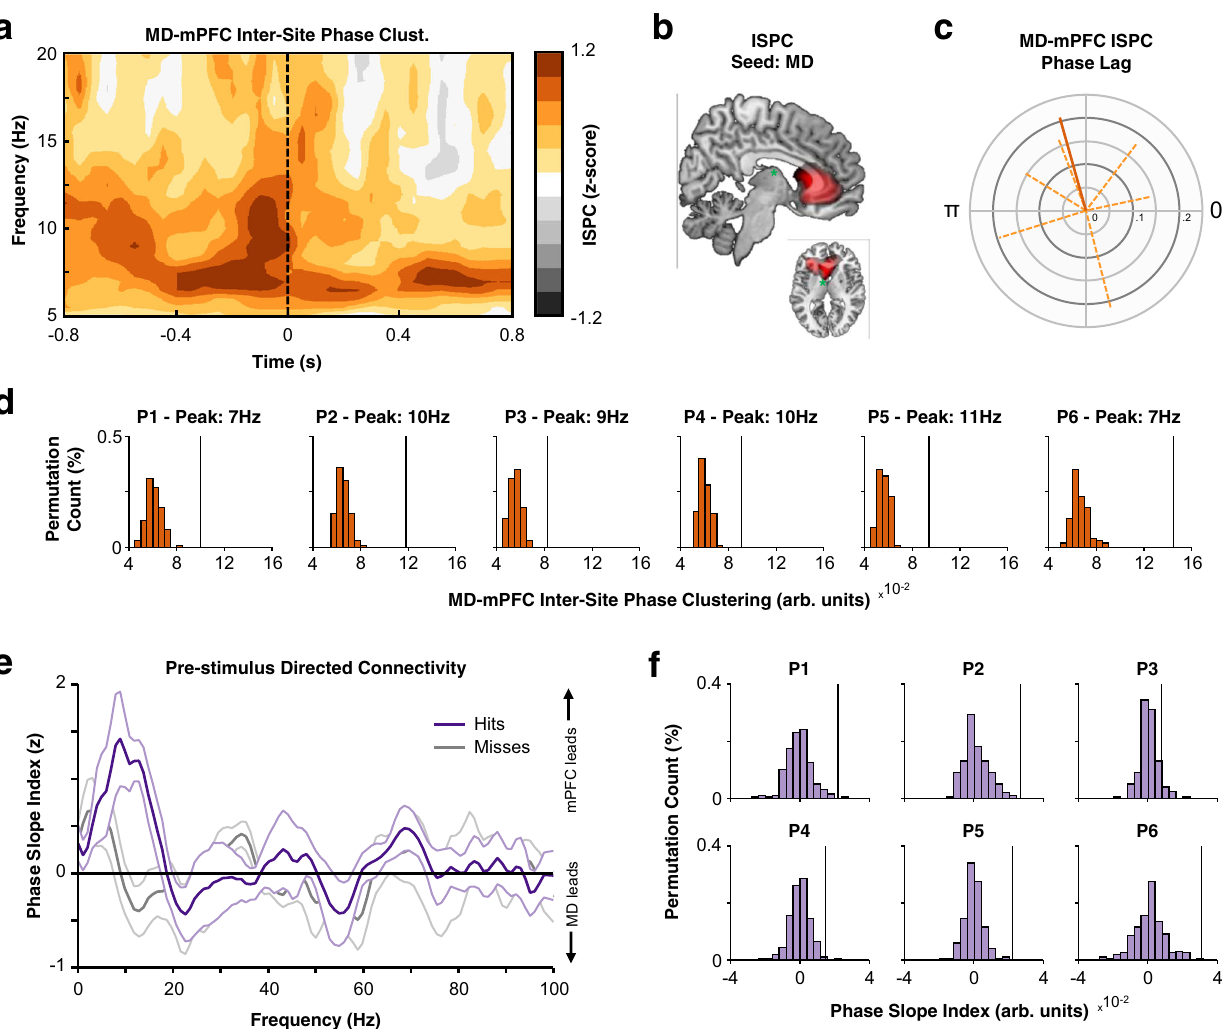
Fig. 2 Corticothalamic connectivity precedes visual detection. a Time-frequency representation of phase-based undirected connectivity between intracranial recordings of the mediodorsal thalamus and MEG recordings of the medial prefrontal cortex. Connectivity peaked prior to stimulus onset, at ~8 Hz. Deeper colours of orange indicate high phase-locking, darker greys indicate low phase-locking. b Pre-stimulus 8 Hz phase-based undirected connectivity between the mediodorsal thalamus and source-localised MEG signals peak in the ipsilateral prefrontal cortex (phase-locking coloured in red; insert: left re fl ects ipsilateral hemisphere, right re fl ects contralateral). Green circle indicates approximate position of mediodorsal thalamic electrode. c Polar plot of mean phase lag between mediodorsal thalamus and medial prefrontal cortex. The dark, solid orange line indicates mean phase lag and mean vector length of the participant-speci fi c phase lag angle; light, dotted orange lines indicate mean phase lag and mean vector length per participant). The scale ranges from zero (i.e., no consistent direction) to one (i.e., perfectly consistent lag across participants/trials). Note that the mean phase lag/vector length across participants was calculated only using the phase lags of the individual participants (that is, the calculation was not weighted by participant- speci fi c mean vector length). d Patient-speci fi c observed connectivity (black line) compared to surrogate distributions (orange histograms; n = 1000 permutations) for individual peak connectivity frequencies. e Frequency spectrum for pre-stimulus directed connectivity between medial prefrontal cortex and mediodorsal thalamus (hits in purple, misses in grey; dark line indicates the mean across participants; shaded area indicates the mean + / − the standard error of the mean across participants [ n = 6 participants]). A positive value indicates that the medial prefrontal cortex leads the mediodorsal thalamus, while a negative value indicates the mediodorsal thalamus leads the medial prefrontal cortex. The medial prefrontal cortex leads the mediodorsal thalamus uniquely for hits. f Patient-speci fi c observed directed connectivity (black line) compared to surrogate distributions (purple histograms; n = 200 permutations) individual peak directed connectivity frequencies. ISPC Inter-site phase clustering, MD mediodorsal thalamus, mPFC medial prefrontal cortex. Source data are provided as a Source Data fi